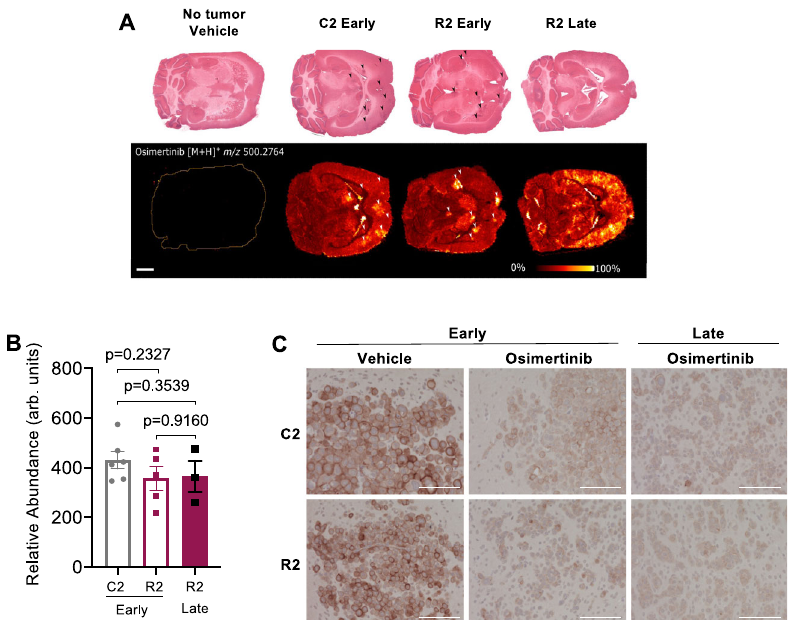
Fig. 2 | Long-term osimertinib resistance in the brain is independent of drug distribution orlack oftarget inhibition.A Representative H&Eimages(top)and MS images (bottom) of adjacent sections of brains harvested from mice with established C2 and R2 brain metastases treated with a single dose of osimertinib ( “ early ” ), or R2 treated with osimertinib continuously for 59 days ( “ late ” ). MS imagesareshownforosimertinibrecordedas[M+H] + at m/z 500.2764.MSimages arealsoshownforacontrolbrain,withoutosimertinibtreatment.ArrowsinC2and R2 “ early ” imagesshowsmallareasofmetastases,whilemetastaticcellsinR2 “ late ” werewidelydispersedinthecortex.Scalebarindicates2mm.Spatialresolutionof MSI experiments is 100 µ m. B Relative abundance of osimertinib (measured in arbitrary units) in tumor tissue. N =6 animals for C2 early, N =5 animals for R2